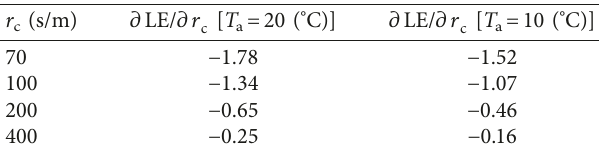
Figure 8: z LE / z r c as a function of r c (m/s) under different meteorological conditions (a) U (cid:29) 2 (m/s), T a (cid:29) 20 ( (W m − 2 ), T a 20 ( ° C), RH 60%, (c) R n · (cid:29) (cid:29) Table 3: Values of z LE / z r c with different r c under R n (cid:29) 600 (W/m RH 0.6, U 2 (m/s) at two different temperatures [ T a (cid:29) (cid:29) ( °